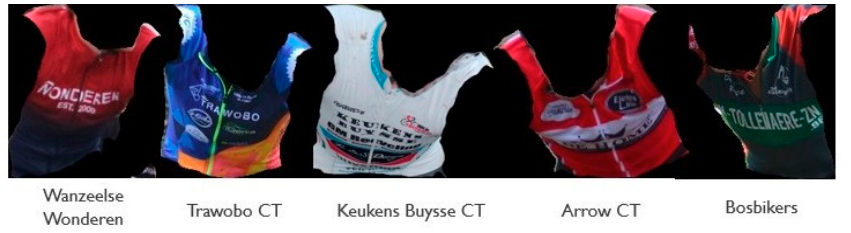
Figure 8. Overview of the five team jerseys that were used to train the team jersey recognition model.